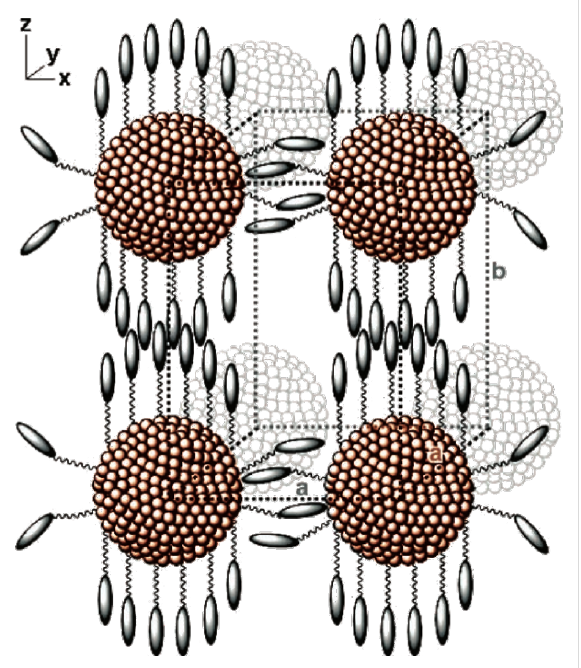
Figure 7: A simplified illustration of the local rectangular arrangement of nanoparticles in a condensed mixed phase. Reprinted with permis- sion from [62]. Copyright 2011 Wiley-VCH